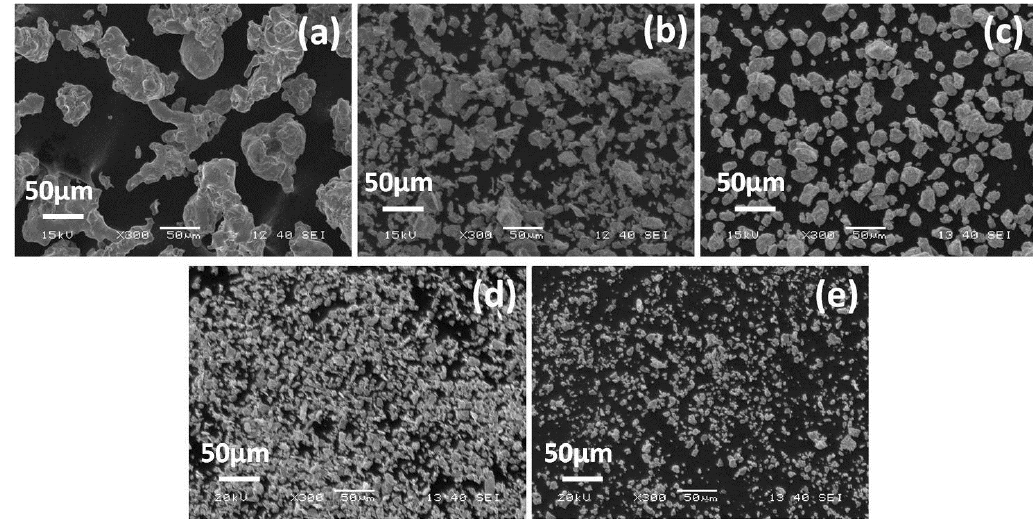
Fig. 3 SEM photographs of powder morphology of alloy A after different milling times: 0h, (b) 5h, (c) 10h, (d) 20h, (e) 40h.